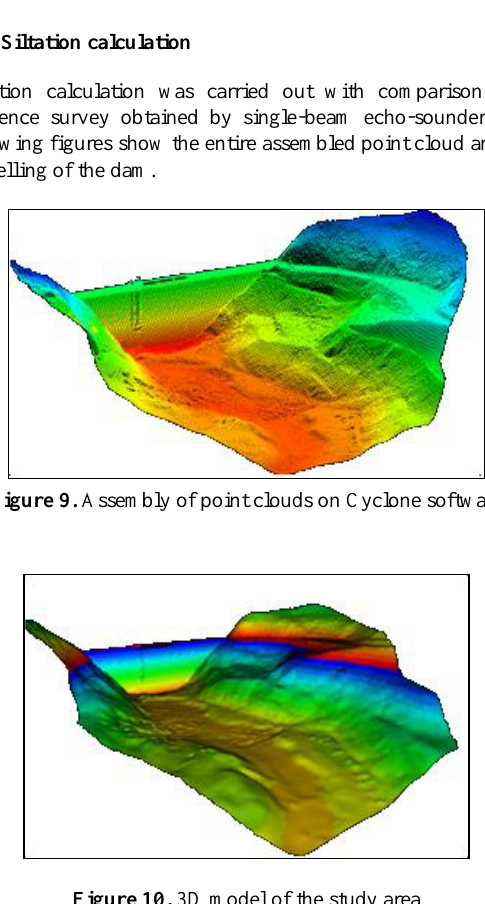
Figure 10. 3D model of the study